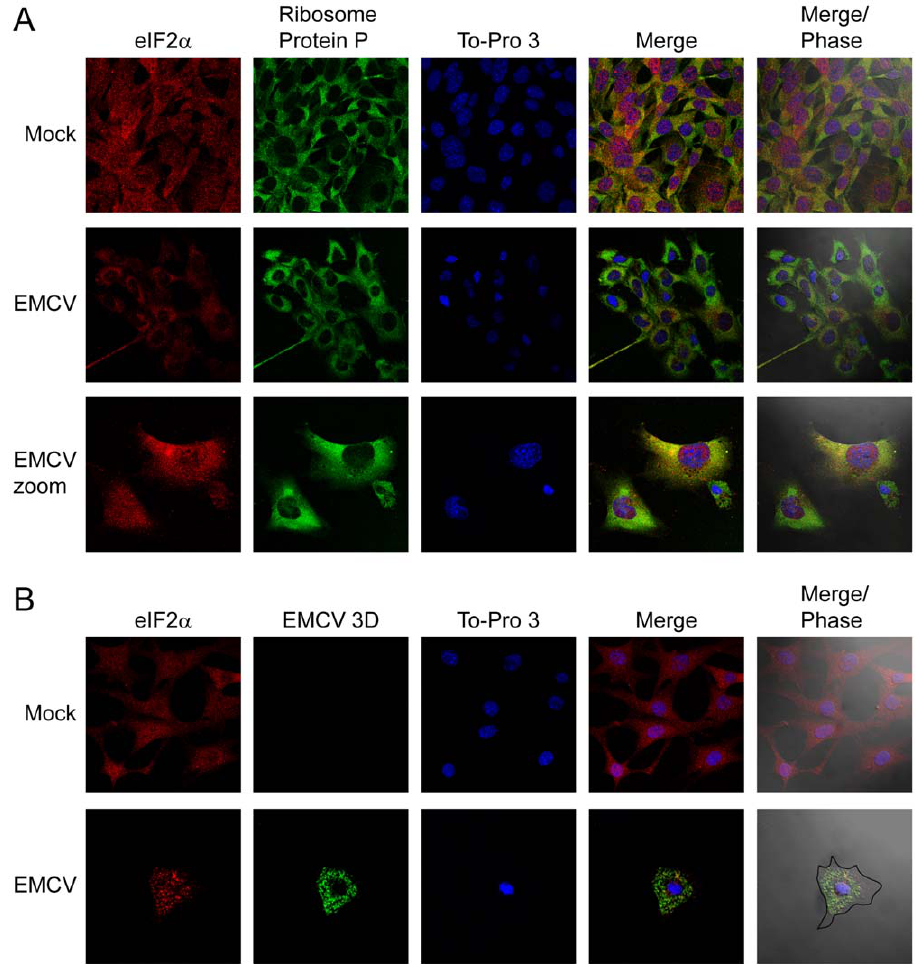
Figure 5. Subcellular localization of eIF2 a , ribosomal protein P and EMCV 3D protein in Mock and EMCV infected cells. Hela cells were seeded on glass coverslips and mock infected or infected with EMCV (10 pfu/cell). At 5 hpi, cells were fixed and permeabilized. A) Ribosomal protein P and eIF2 a were detected by indirect immunofluorescence in mock- and EMCV-infected cells. ToPro 3 indicates the localization of the nucleus. B) Localization of eIF2 a and EMCV 3D proteins. The cell outline was defined by differential interference contrast microscopy (Nomarski).